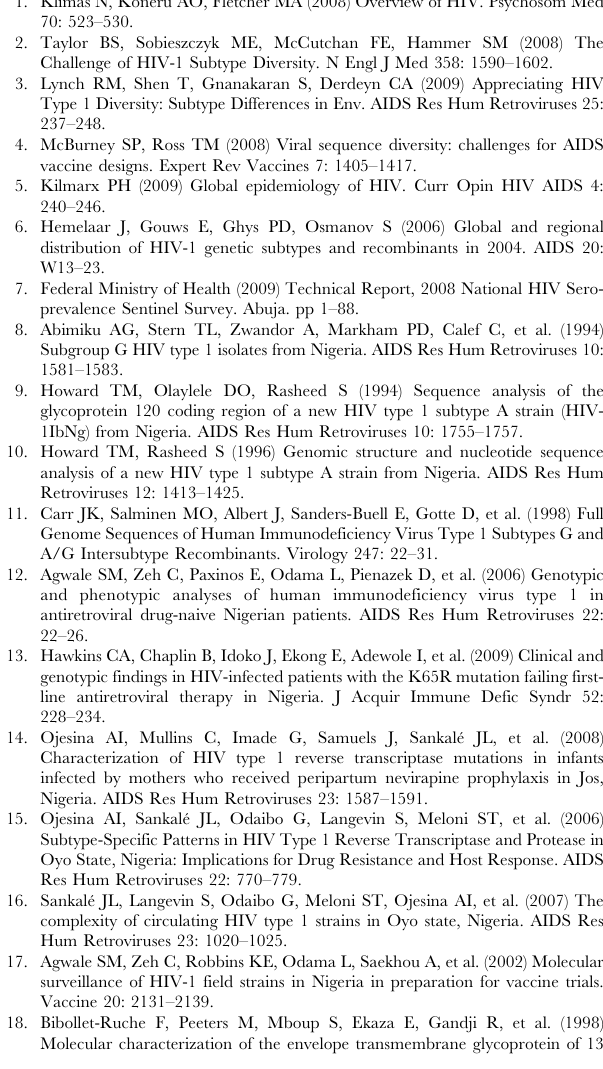
Table S2 Date of Most Common Recent Ancestor (MRCA) and parameters estimated from BEAST.